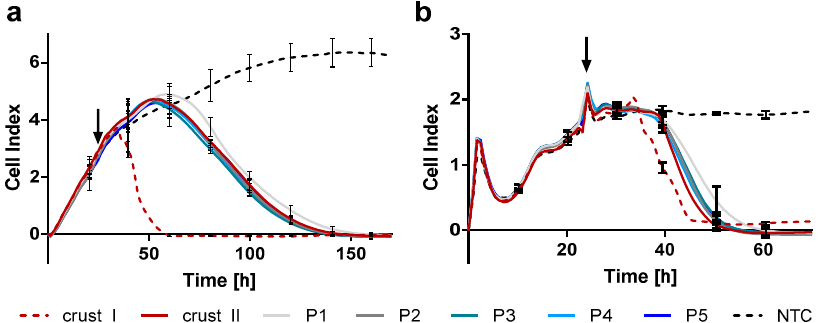
Figure 2. Real-time cell analysis of HEp-2 and Rat-2 cells infected with CPXV crust and passages reveals no differences among passages but heterogeneities of the crust. ( a ) HEp-2 and ( b ) Rat-2 cells were seeded in 96-well E-plates and cell adherence was measured over time. About 24 h after seeding, cells were infected with purified CPXV originating from a rat crust or from different passages (P1–P5) at an MOI of 0.1 (arrow). Shown are mean values ± SD of biological triplicates of passages measured in technical quadruplicates ( n = 12) or six technical replicates of the crust, which cluster in two different courses (crust_I and II) with each n = 3. NTC: non-infected cells.